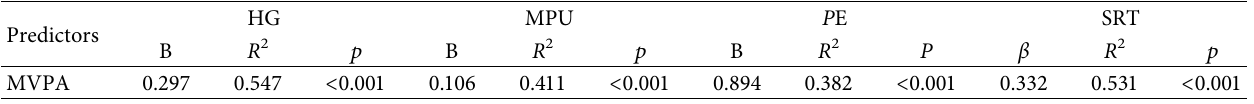
Table 3: Linear regression model relationship between physical fitness and MVPA ( n � 2970).